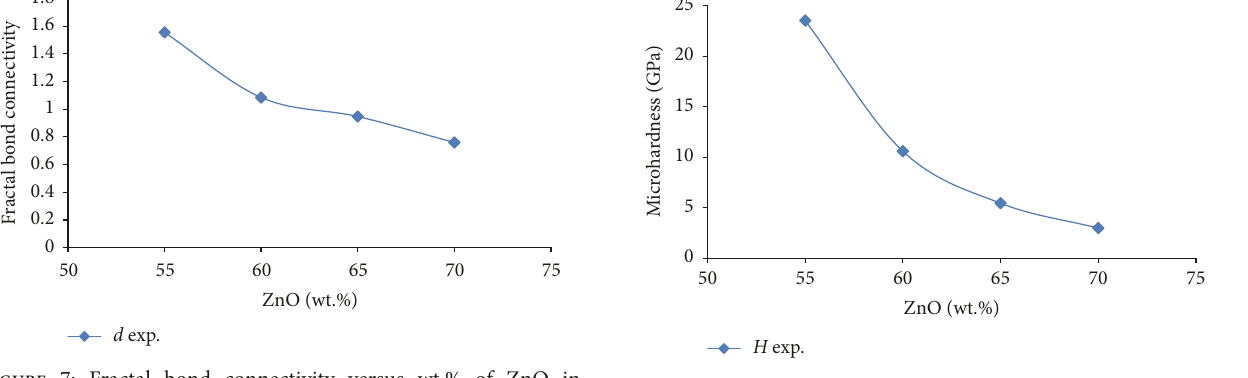
Figure9:Microhardnessversuswt.%ofZnOinZnO–SiO 2